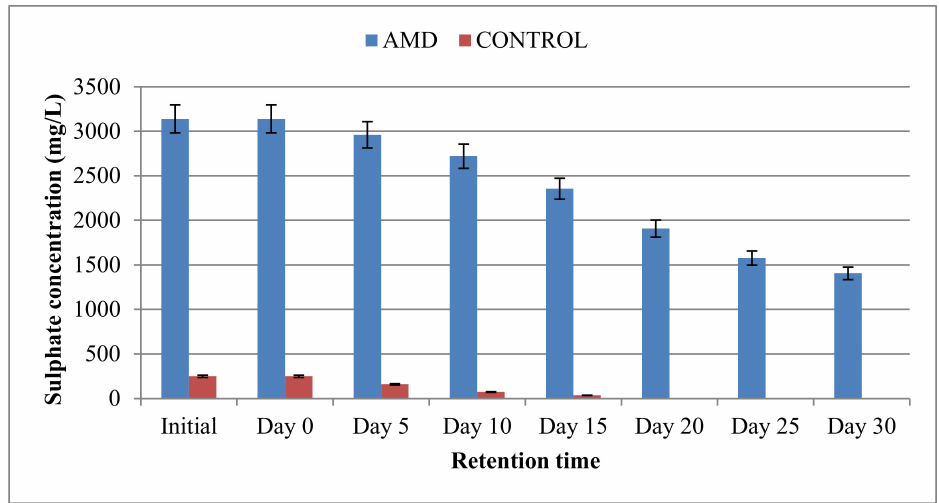
Figure 2. The effect of SSVF-CW on the removal of sulfate from AMD in 30 days HRT under a hydraulic loading rate of 3